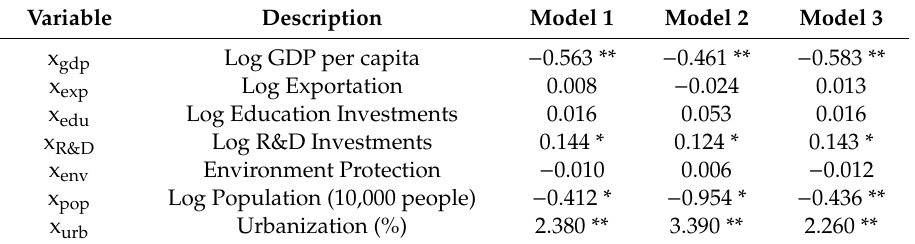
Table 3. Stochastic frontier models’ estimation results (NT = 240 observations).